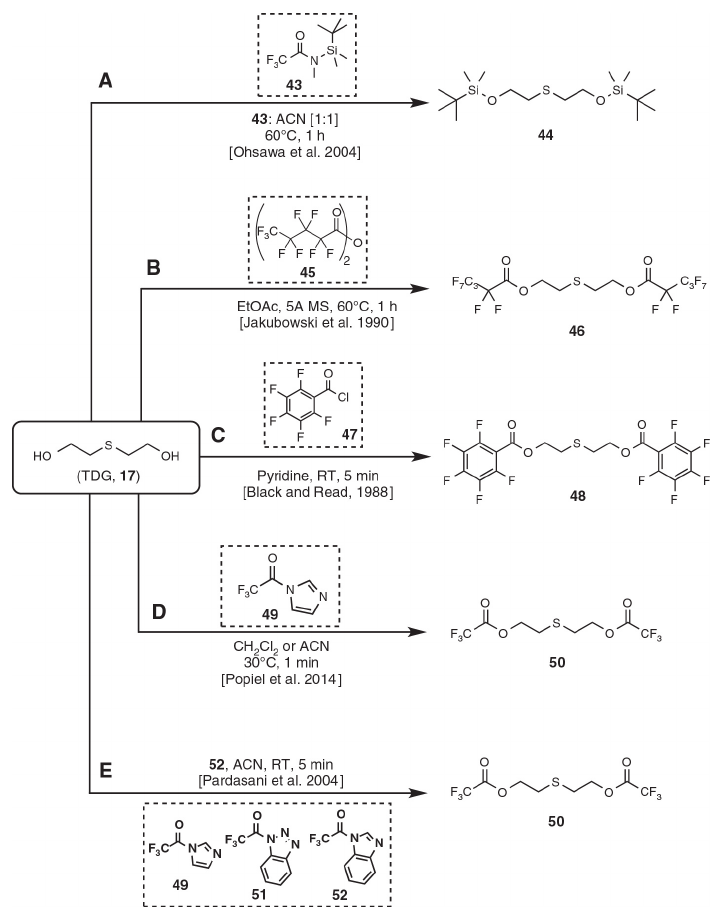
Figure 9: Derivatization of TDG employing BSTFA (A) and various fluorine-containing derivatization agents (B – E).